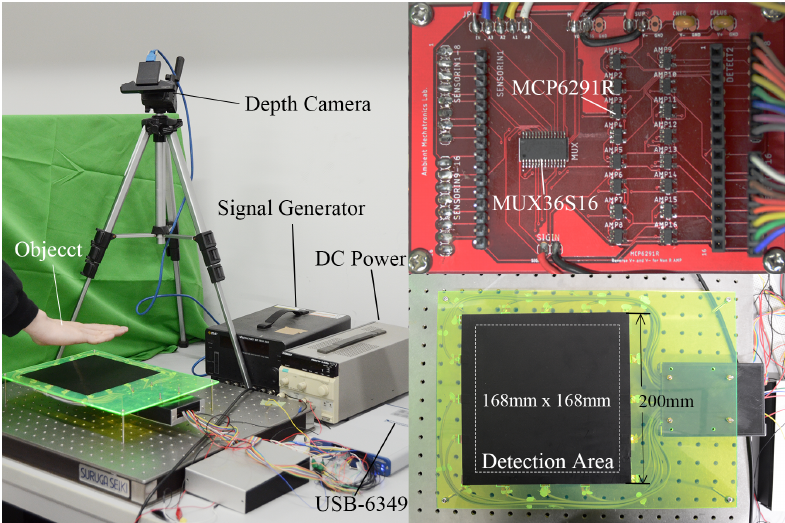
Figure 3. Outline of the sensor structure. Voltage followers are used to improve performance.